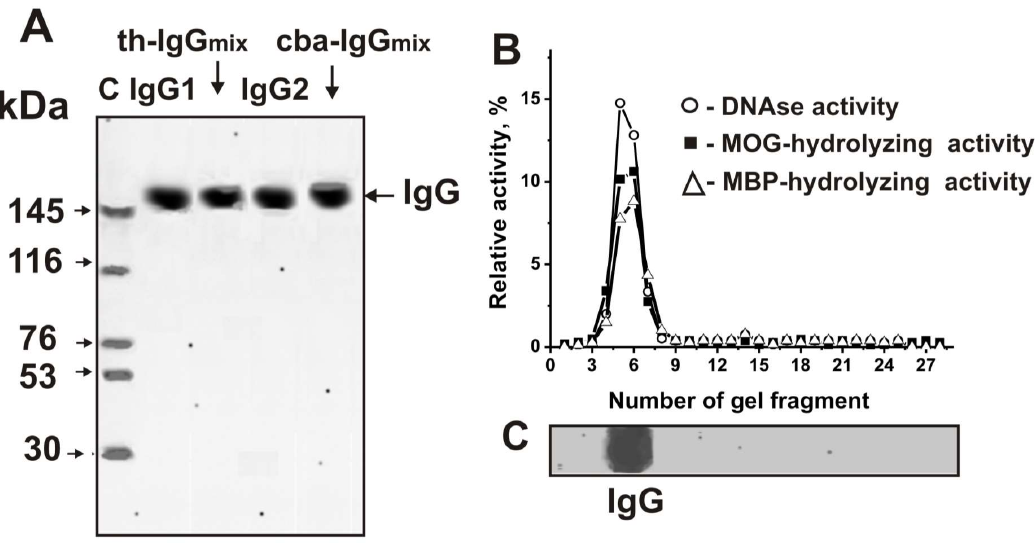
Figure 8. The homogeneity analysis by SDS-PAGE of 10 μg IgG1 and IgGmix corresponding to Th mice and 10 μg IgG1 and IgGmix corresponding to CBA mice under non-reducing conditions ( A ); silver staining. The arrows (lane C (A)) show the positions of proteins with known molecular masses. The relative activities (%) of eluate gel fragments in the hydrolysis of DNA (o), MOG ( ■ ), and MBP (∆) by th-IgGmix were determined using the extracts of gel fragments (2–3 mm) ( B ). The position of IgGs is shown on Panel, C . A complete hydrolysis of all substrates after incubation was taken as 100% (B). The errors of the relative activity determined from two independent experiments did not exceed 7%–10%.